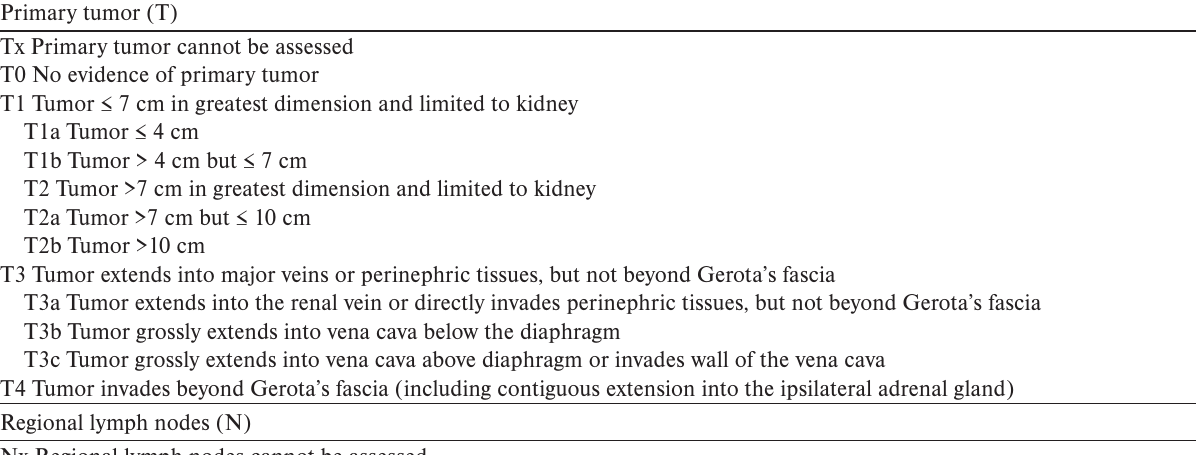
Table 2. TNM classification of RCC according to AJCC